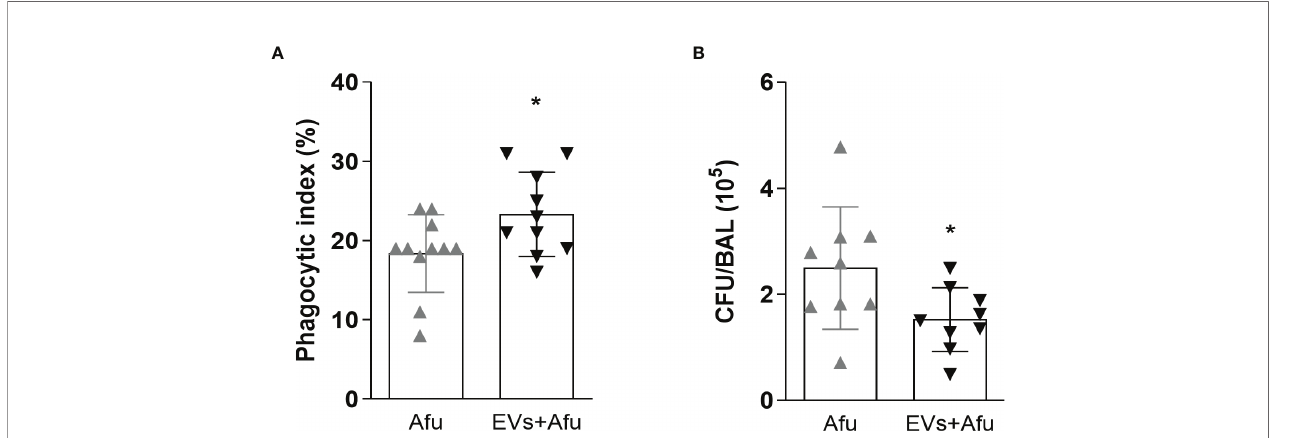
FIGURE 3 | Immunization with EVs impacts in phagocytic capacity and fungal clearance. C57BL/6 mice were immunized twice with 2.2 × 10 9 EVs and challenged with 1 × 10 8 A. fumigatus conidia. Phagocytosis (A) and fungal killing (B) were evaluated in BAL. Data are mean ± SD of N = 5-6 animals per group. *P < 0.05 when compared to the Afu and EVs+Afu group, as determined by two-sample independent t-tests. Data are representative of two